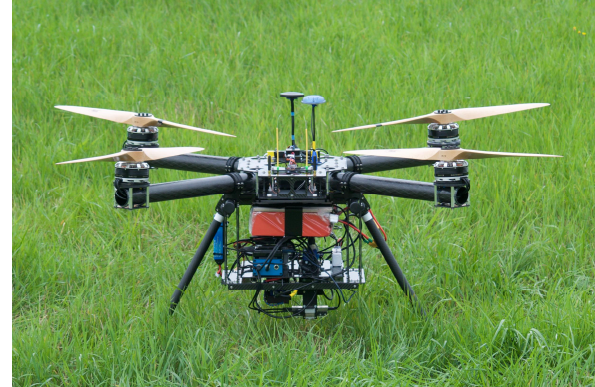
Figure 1 DroneKnowledge hyperspectral imaging system mounted under the Avartek